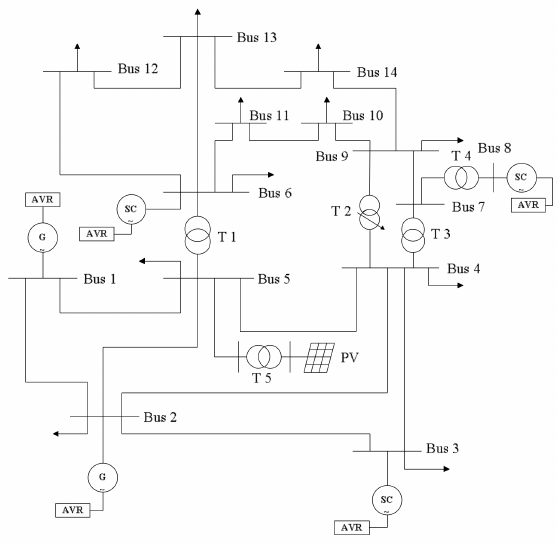
Figure 8. The IEEE 14-bus system with a large-scale